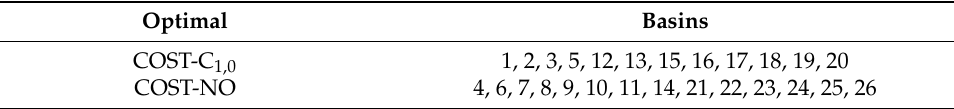
Table 11. The results of each basin about the optimal